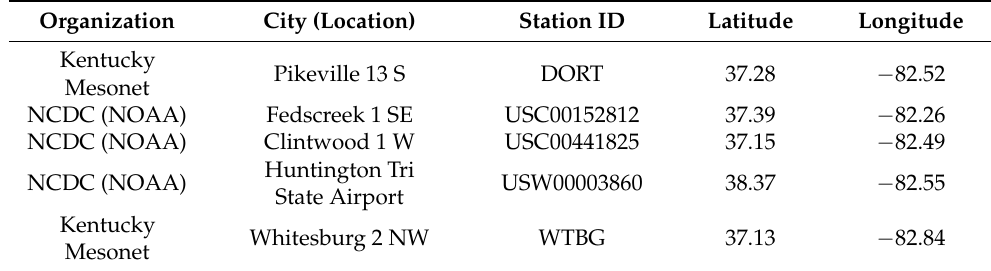
Table 1. List of weather stations that provided monthly precipitation data for the project.